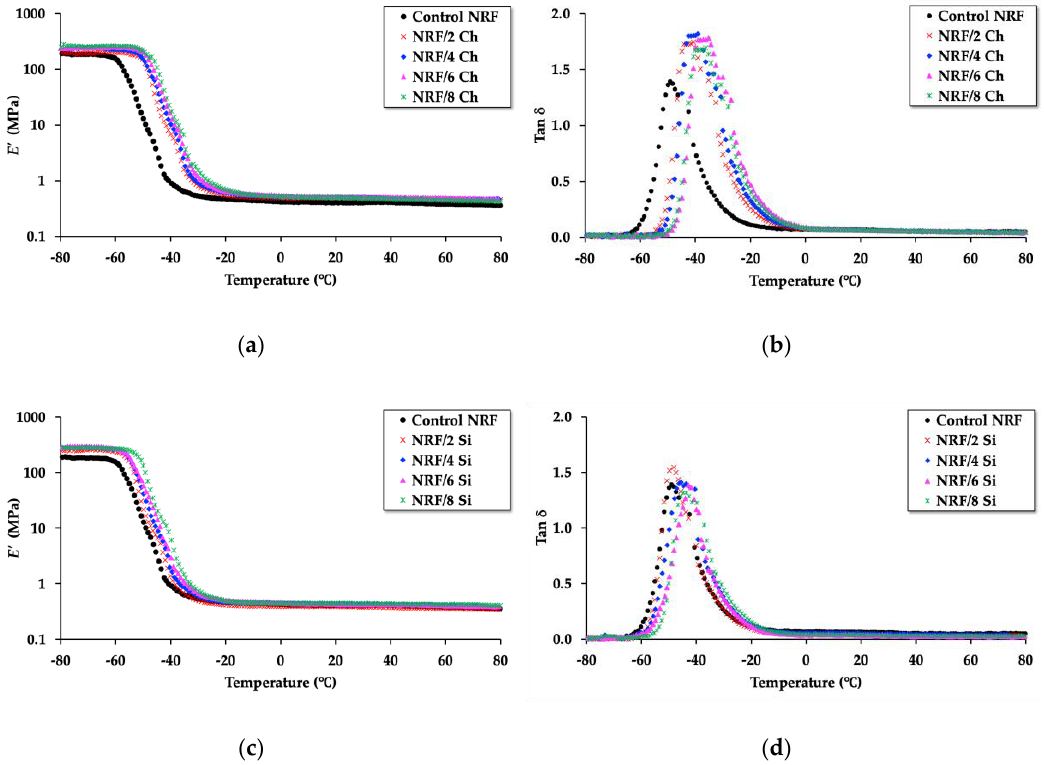
Figure 11. Storage modulus ( E’ ) and tan δ as a function of the temperature of the NRF with various fillers: ( a ) storage modulus of the NRF with charcoal loading compared to the control NRF; ( b ) tan δ of the NRF with charcoal loading compared to the control NRF; ( c ) storage modulus of the NRF with silica loading compared to the control NRF; ( d ) tan δ of the NRF with silica loading compared to the control